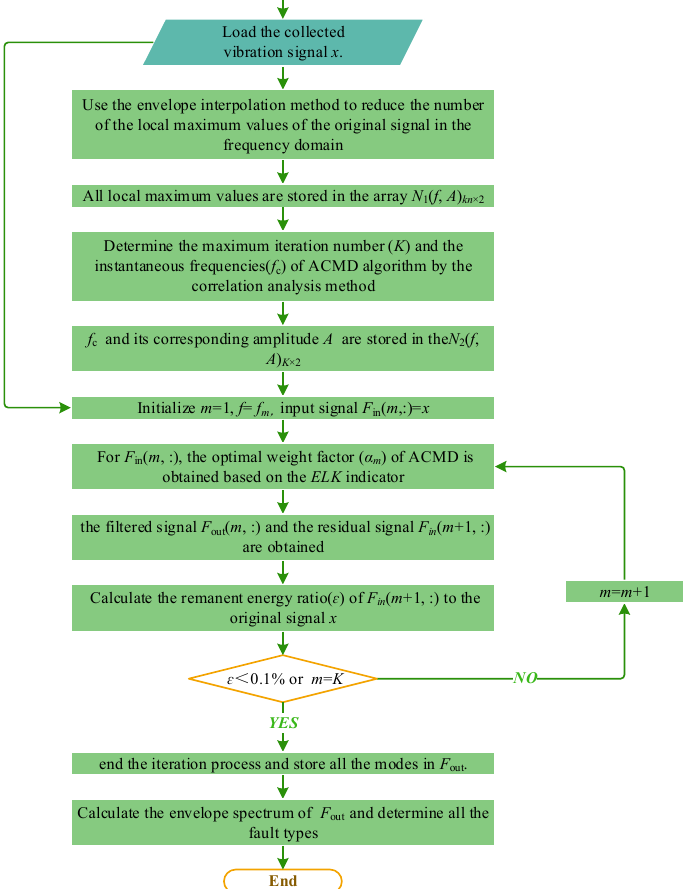
14 of 30 Figure 11. Analysis results of each mode of the simulated inner race fault signal: ( a ) frequency spectrum; ( b ) envelope spectrum. 4. Application Procedures of the Proposed Method The entire flowchart of the proposed IMACMD method is displayed in Figure 12, and the specific steps to apply the method for bearing fault diagnosis are given below: Step 1 : Load the collected vibration signal x . Step 2 : Use the envelope interpolation method to reduce the number of local maximum values of the original signal in the frequency domain. All local maximum values are stored in the array N 1 ( f , A ) kn ×2 . Step 3 : Determine the maximum iteration number ( K ) and the instantaneous frequencies ( f c ) of the ACMD algorithm by the correlation analysis method, denoted as N 2 ( f , A ) K ×2 . Step 4 : Initialize m = 1, f = f m , and input signal F in ( m , :) = x . Step 5 : For F in ( m , :), the optimal weight factor ( α m ) of ACMD is obtained based on the ELK indicator.